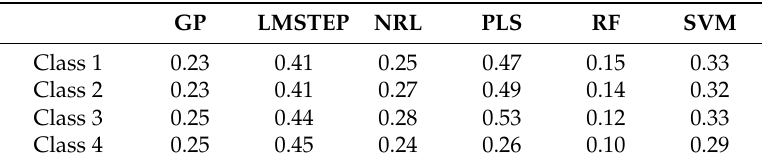
Table 2. The means of relative error for Gaussian processes (GPs), stepwise linear models (LMSTEP), nonlinear regression using a logistic model (NRL), partial least squares regression (PLS), random forest (RF), and support vector machine (SVM).